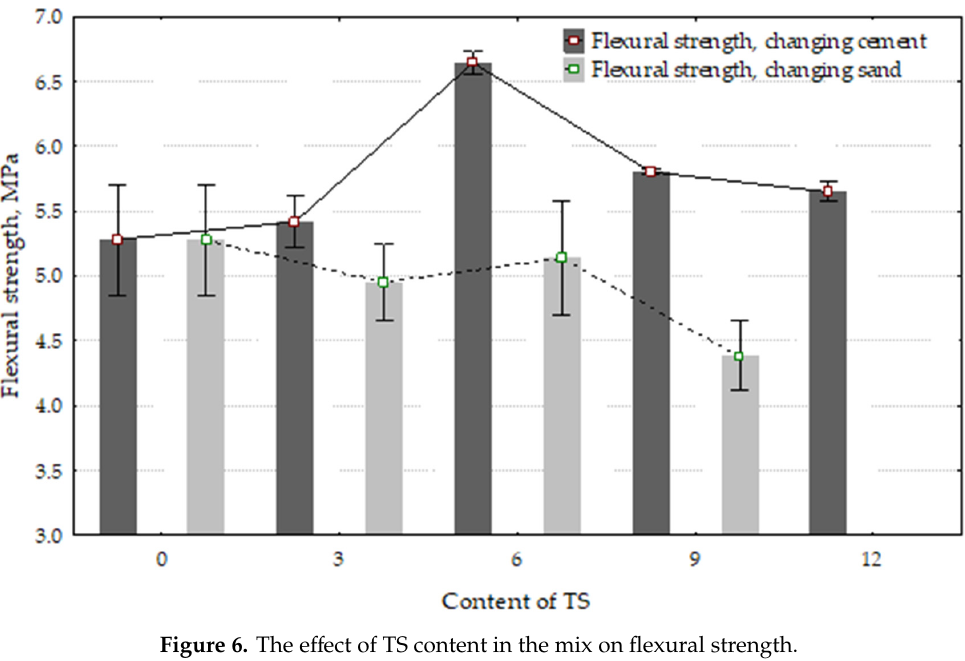
Figure 6. The effect of TS content in the mix on flexural strength.